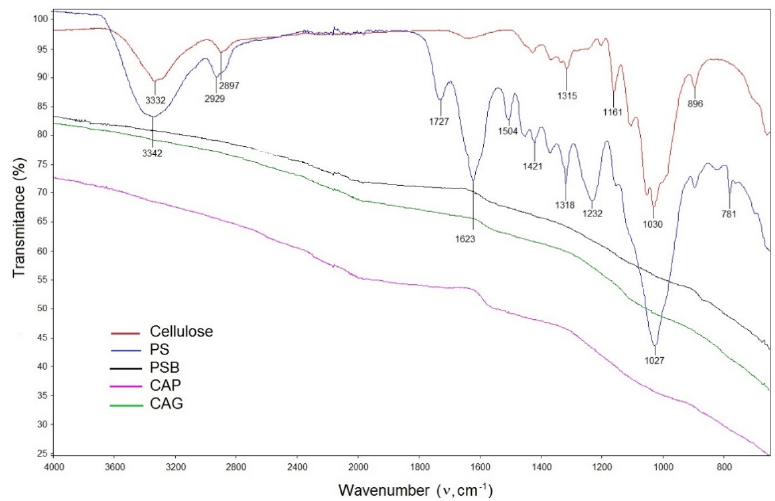
Figure 1. Characterization of the biochar via FT-IR for the PS, PSB, CAP, CAG and cellulose.